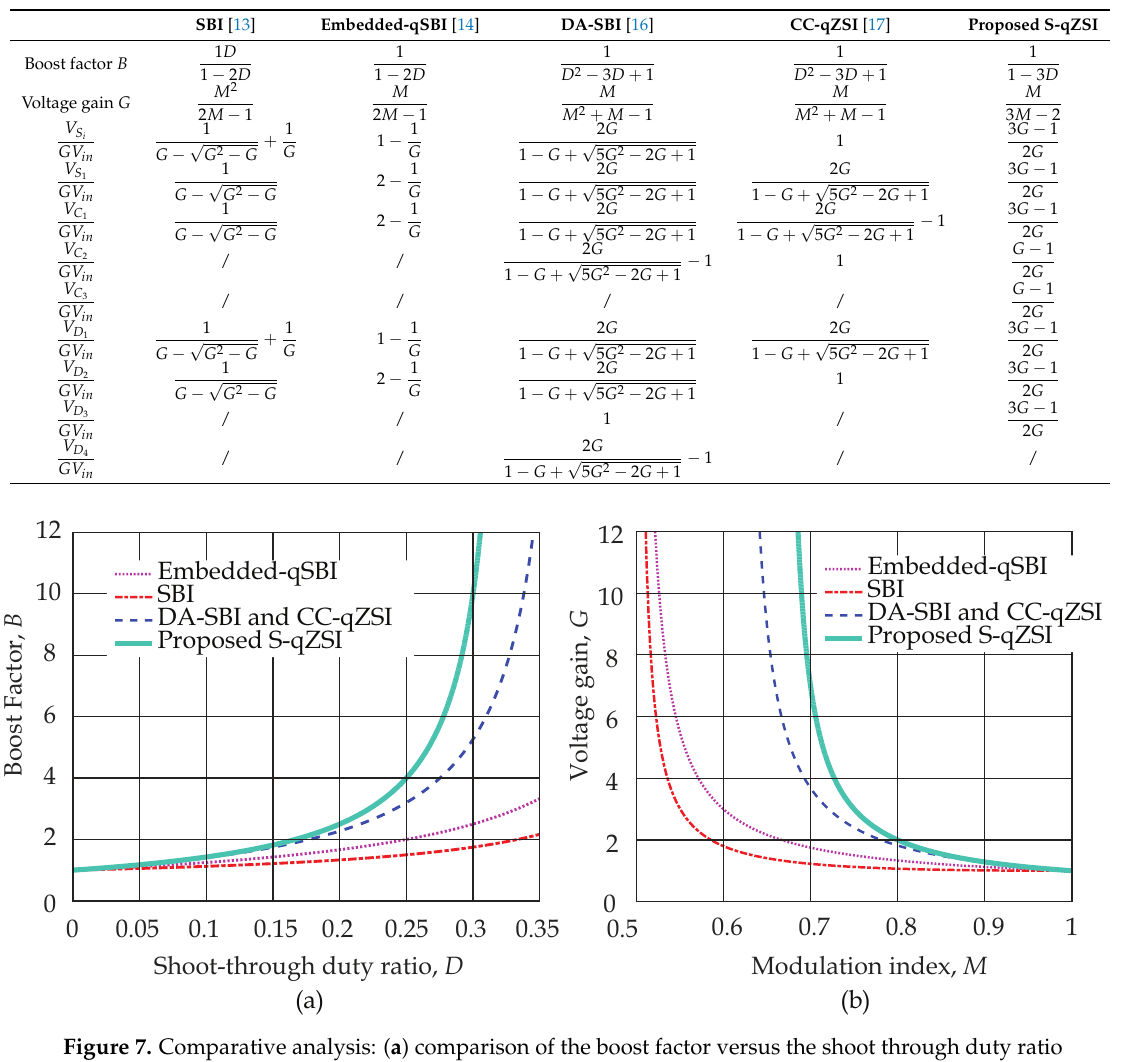
Table 3. Benchmarking of boost factor, voltage gain, and voltage stresses among selected impedance source inverters.